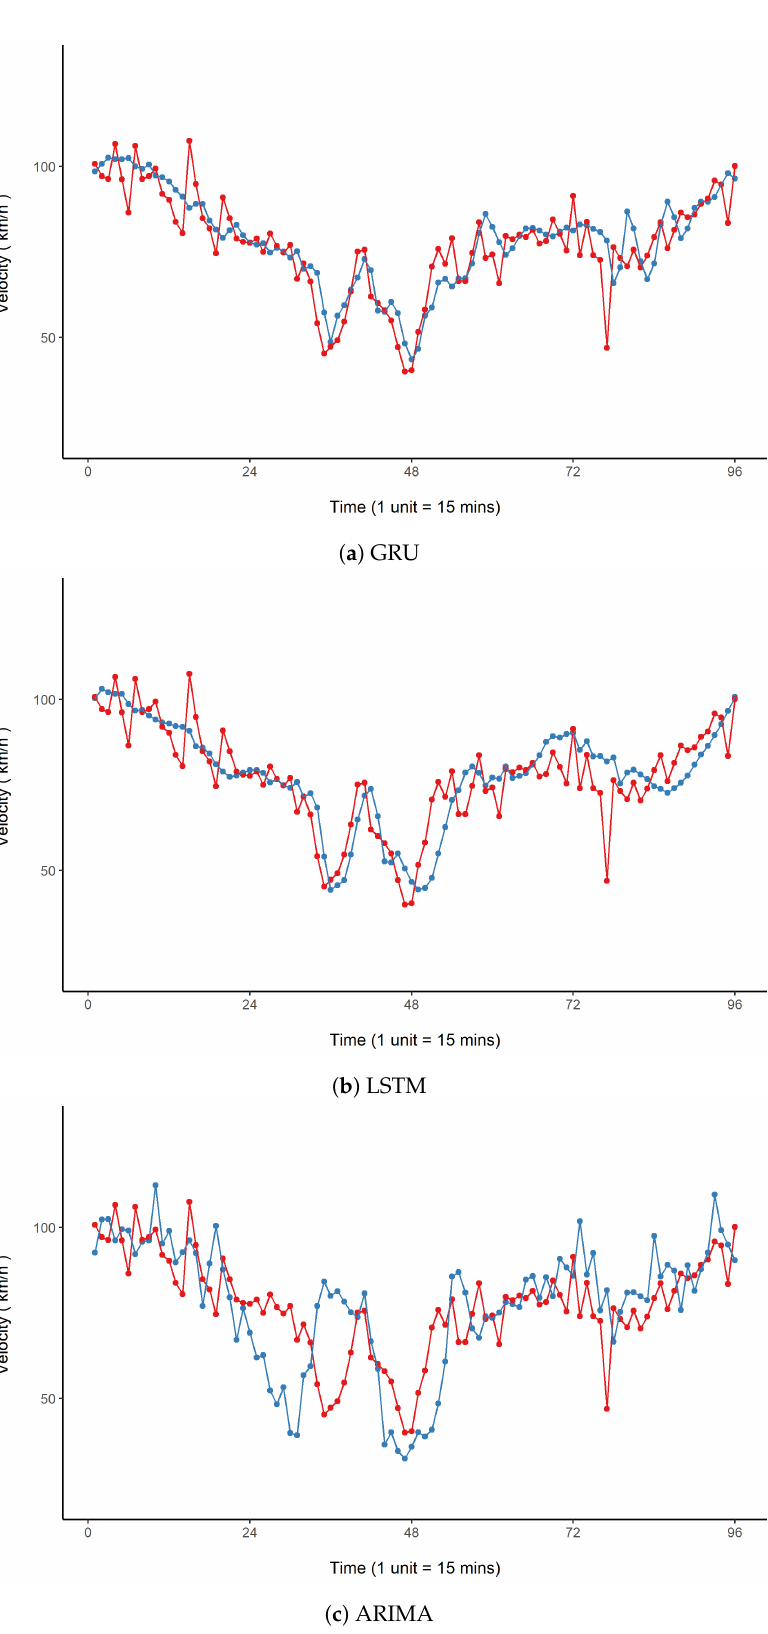
Figure 10. Performance comparisons in regular lanes: red color for ground truth and blue color for